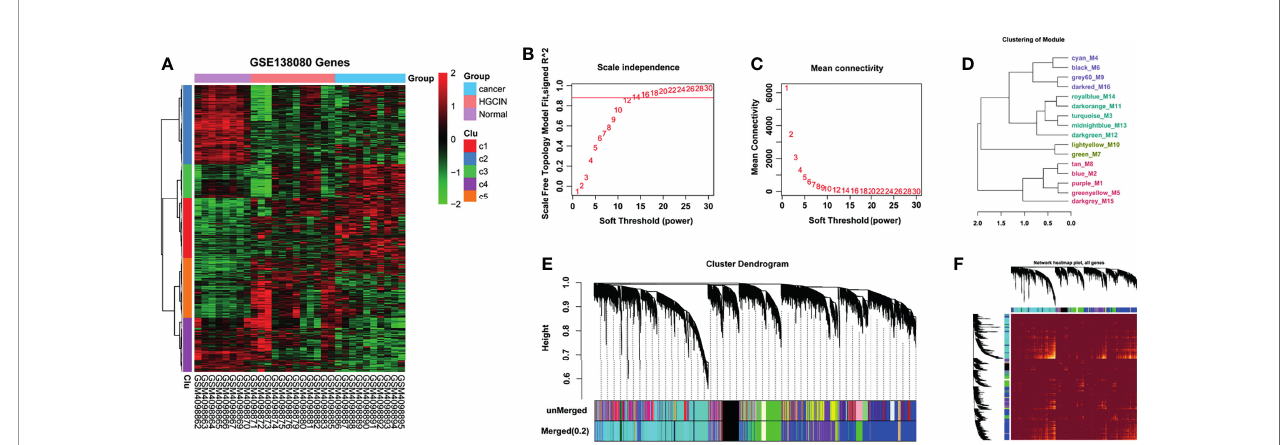
FIGURE 1 | WGCNA on the dynamic progression of HPV-associated CCa. (A) Hierarchical clustering analysis of mRNAs differentially expressed in cervical samples spanning from normal, to CIN and CCa (fold change > 1.5 and p < 0.05). Eight normal, 12 CIN, and 10 CCa tissues in GSE138080 were used to conduct bioinformatics analysis after PCA. (B, C) Network topology analysis at different soft-thresholding powers. R2 > 0.8 and mean connectivity < 100 when b = 12, indicating that the co- expression network was a scale-free topology. (D) Cluster dendrogram based on module eigengenes. (E) The cluster dendrogram of co-expression network modules. The mRNAs with highly similar expression patterns were placed in the same module using the adaptive branch pruning algorithm. (F) An adjacency heatmap showed the topological overlap matrix among all 12,524